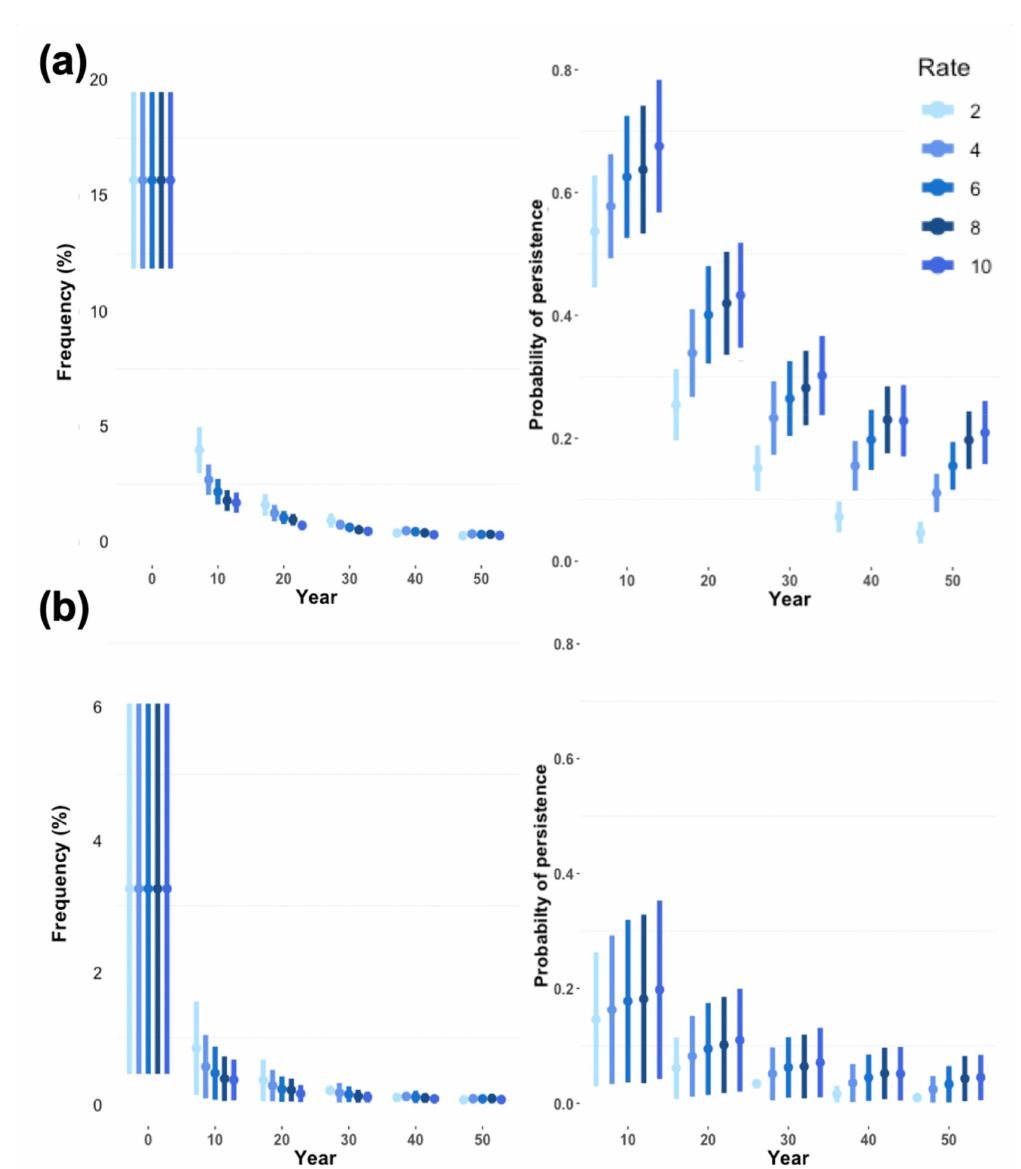
Figure 6. Mean frequencies ± 1 SD and the probability of persistence ± 1 SD of locally unique alleles with starting frequencies of >10% ( a ) and <10% ( b ) in the lowland population. Simulations began with 20 Yellingbo individuals, supplemented with different numbers of highland individuals per year (Rate). Frequency and probability of retention values were output every ten years, with values calculated from 200 replicate runs of each scenario. A carrying capacity of 1000 was